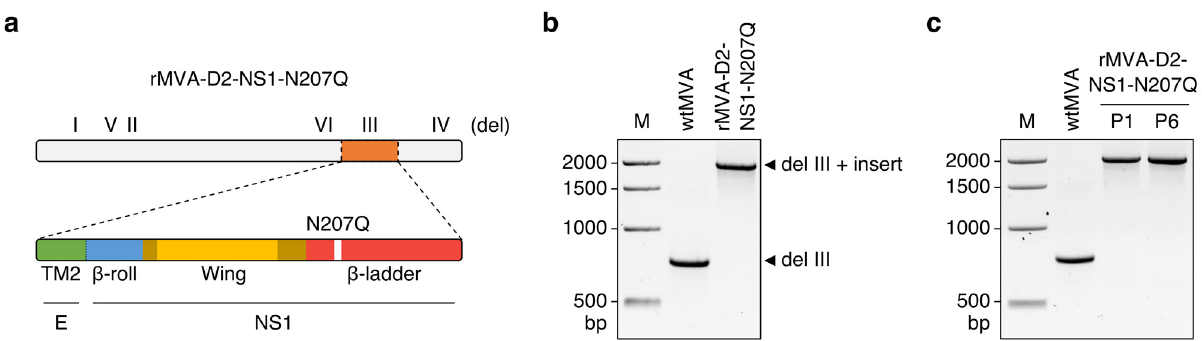
Figure 1. Construction and genetic characterisation of rMVA-D2-NS1-N207Q. ( a ) Schematic representation of rMVA-D2-NS1-N207Q. Top shows the approximate location of the transgene (orange) and the major deletion sites (del) I–VI in the MVA genome. Bottom shows the properties of the transgene product. The N-terminal β -roll is coloured blue (amino acids 1 to 29), the α / β subdomain of the wing domain is depicted in yellow (aa 38–151), connector subdomains within the wing domain are shown in gold (aa 30–37 and 152–180), and the C-terminal β -ladder is coloured red (aa 181–352). The N207Q substitution is highlighted in white. The second transmembrane domain (TM2) of the envelope (E) protein is shown in green. The dotted line between TM2 and β -roll indicates post-translational cleavage. ( b ) Viral genomic DNA was extracted from stocks of non-recombinant, wild-type MVA (wtMVA), and rMVA-D2-NS1-N207Q, and analysed by del III–specific PCR. M, 1 kb DNA ladder. ( c ) rMVA-D2-NS1-N207Q stock (passage 1 [P1]) was passaged five times in